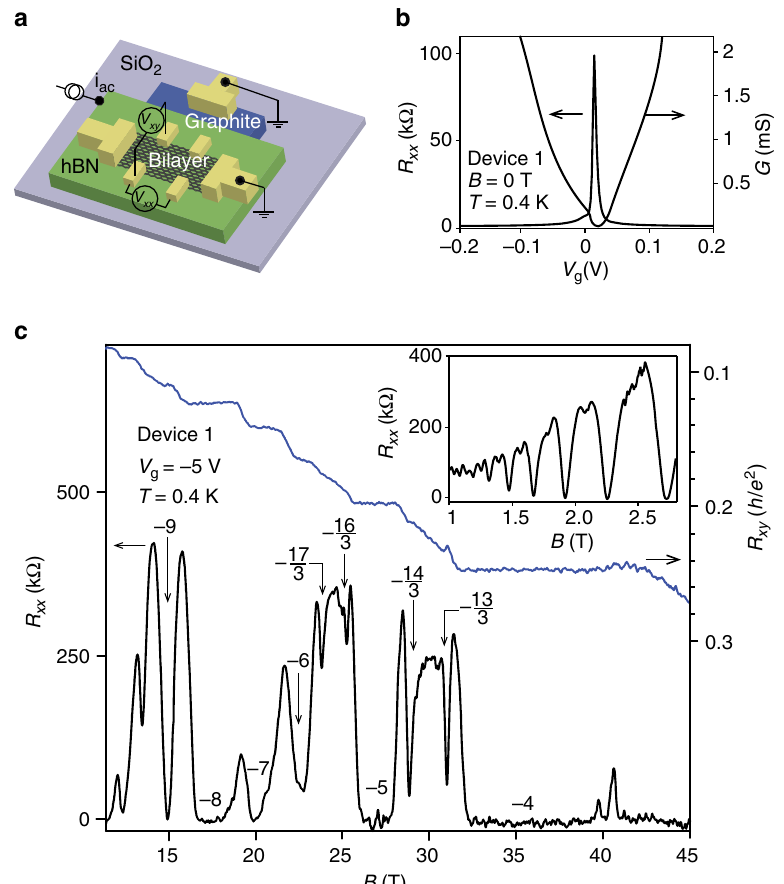
Figure 1 | Device schematic and transport characteristics. ( a ) Schematic of our bilayer graphene device design. ( b ) Zero-field resistance R xx and its inverse, conductance G , as a function of graphite back-gate voltage V g for device 1 (optical image in Supplementary Fig. 1). ( c ) Magnetoresistance R xx and Hall resistance R xy as a function of magnetic field B at V g ¼ (cid:2) 5V. Corresponding Landau level filling factors are labelled. Inset: low-field magnetoresistance with Shubnikov-de Haas oscillations showing the onset of degeneracy breaking among the integer